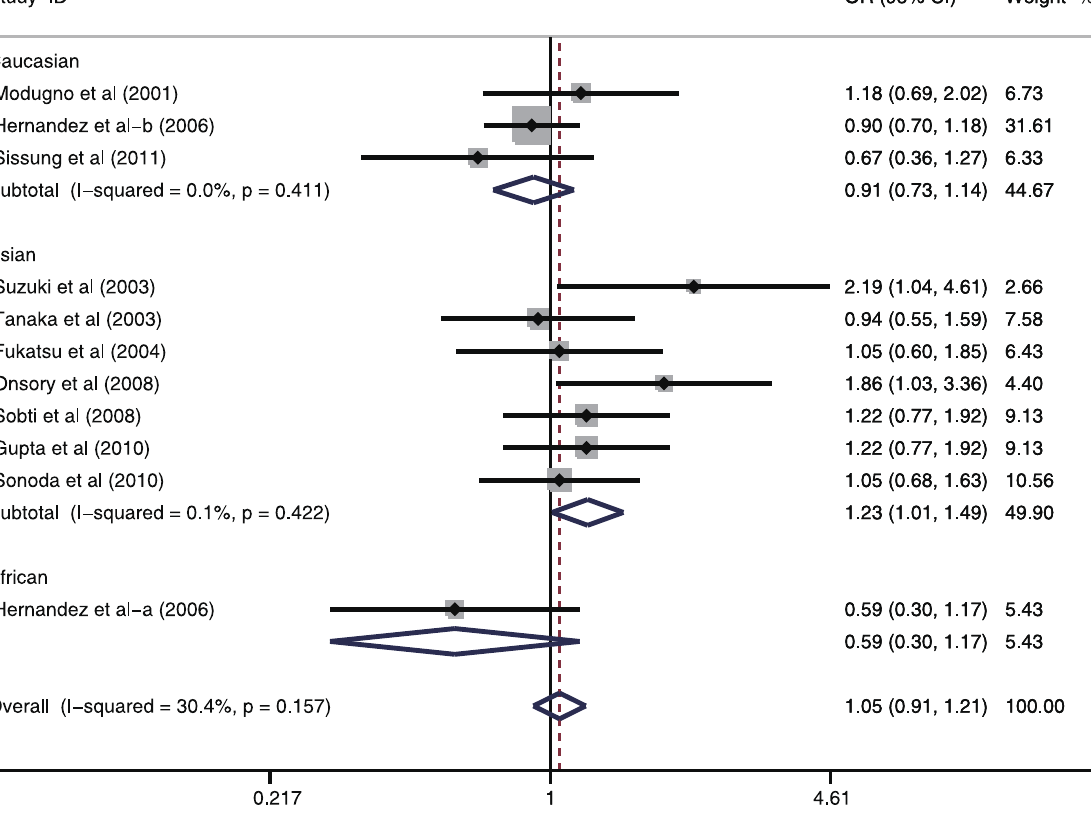
Figure 2. Subgroup analysis by ethnicity of ORs with a random-effects model for associations between ESR1 PvuII (C . T) polymorphism and prostate cancer risk under dominant model (TT + TC vs. CC).